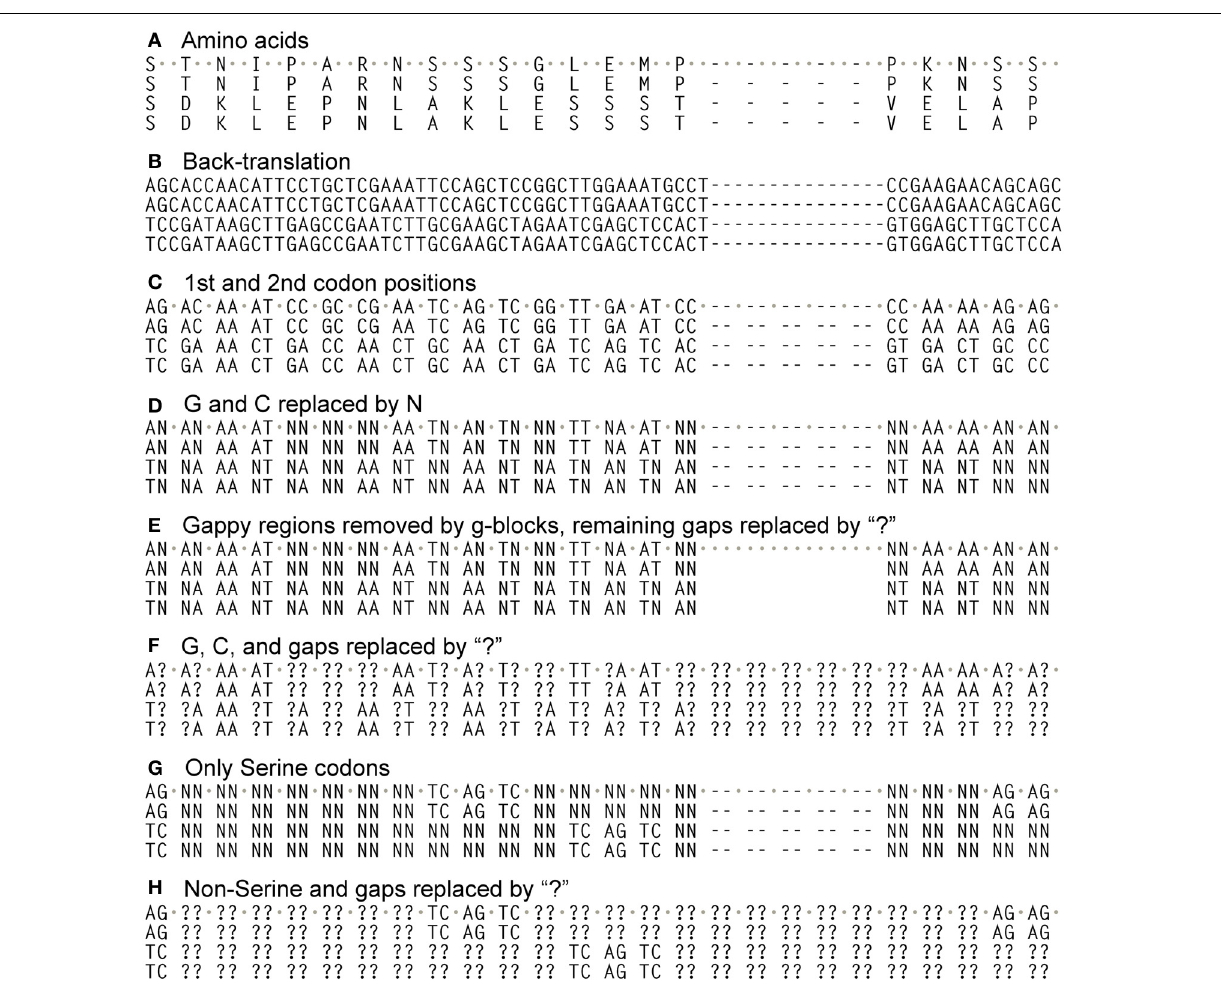
TNT. This alignment then had gappy regions removed by the program Gblocks (E) or had all of its GC bases and gaps converted to “?” (F) , which is read as “any nucleotide or gap” in TNT. The alignment in B also had all codon positions except those coding for Serine converted to “N”, then the 3rd codon positons removed (G) . This also had all Ns and gaps converted to “?” (H)